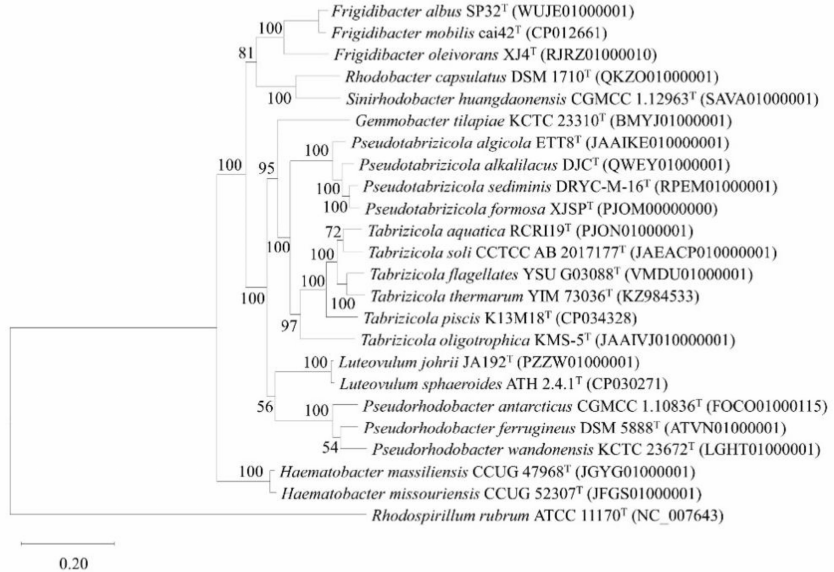
Figure 2. The IQ-TREE based on 120 ubiquitous single-copy proteins. Percentages bootstrap values (1000 replicates) are shown at branch nodes. Rhodospirillum rubrum ATCC 11170 T was used as the out-group. Bar, 0.20 substitutions per nucleotide